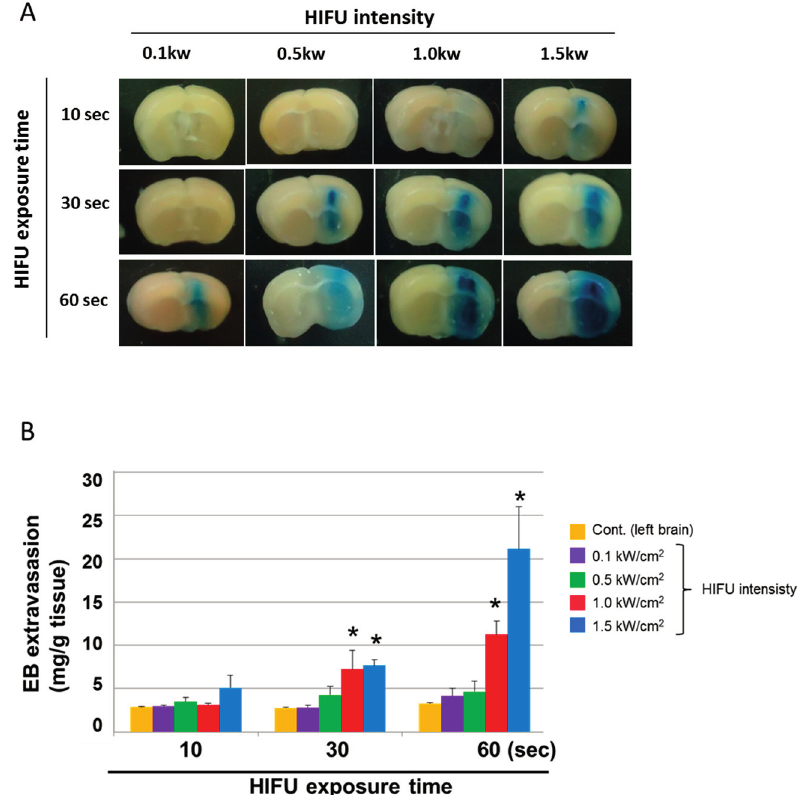
Figure 3. The amount of EB extravasation in the right brain (HIFU-exposed site). ( A ) Distribution of BBB disruption by extravasation of EB. Right brain: HIFU-exposed site. Left brain: control (non-exposed site). ( B ) The amount of EB extravasation in the right brain. The mice were injected into the tail vein with EB 100 mg/kg. After 5 min, the mouse was injected with Bubble liposomes (100 μ g/mouse) and exposed to HIFU with 3.5 MHz, 10% duty, and 1.5 kw/cm 2 . After three hours, each tissue was corrected. The HIFU exposure times were 10, 30, or 60 s. The intensities were 0.1, 0.5, 1.0, or 1.5 kW/cm 2 . Each value represents the mean S.D. ( n = 4). * p < 0.05 vs. cont. EB: Evans